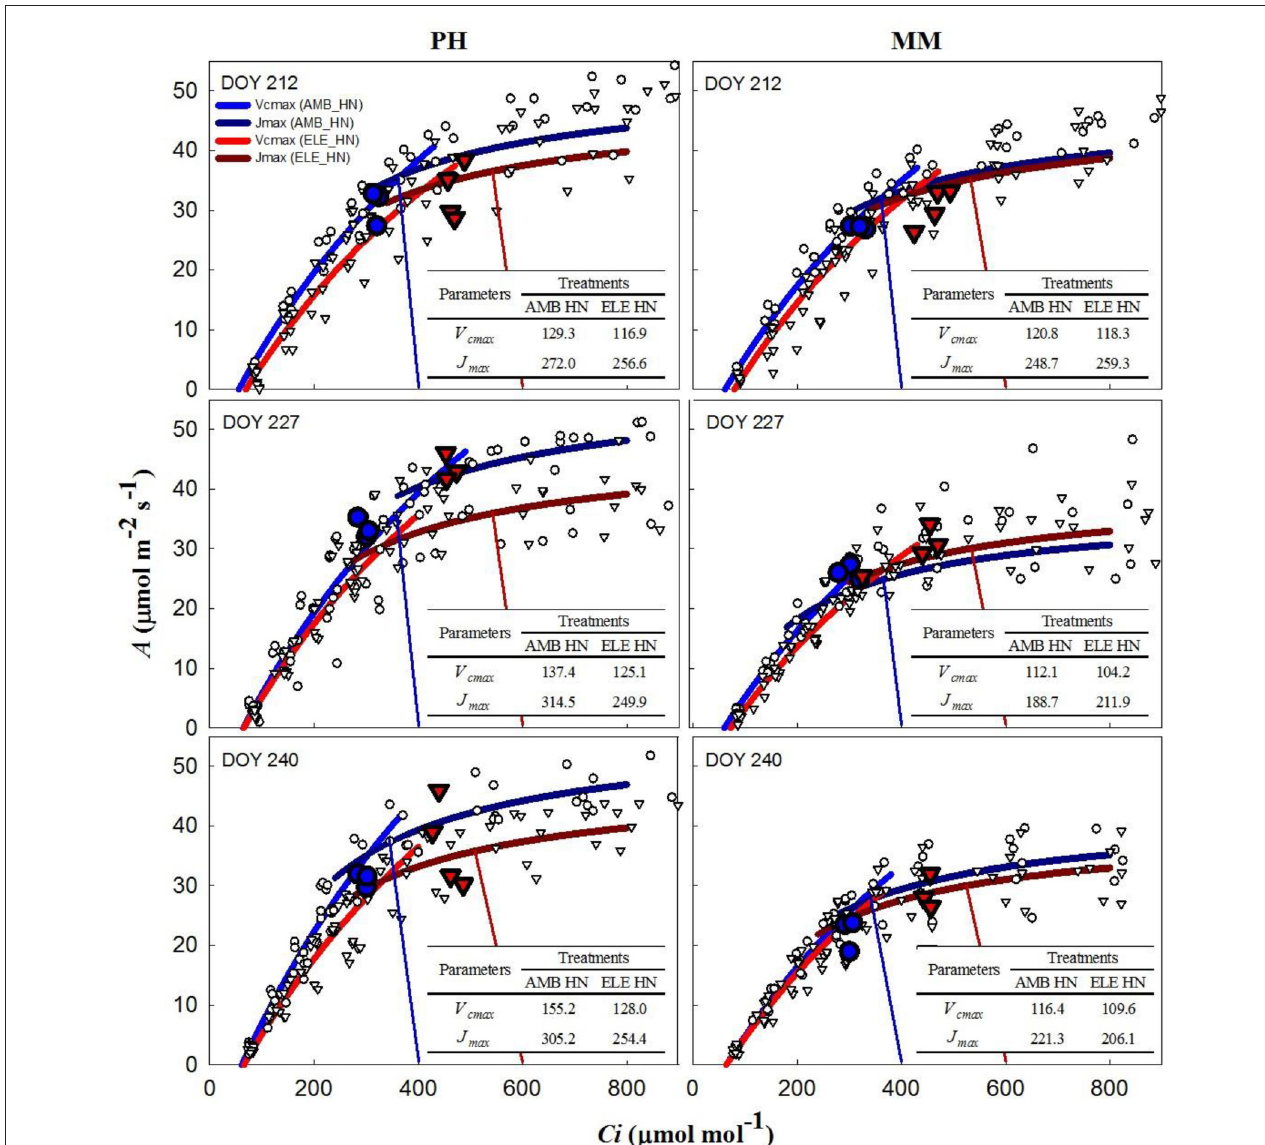
FIGURE 3 | Fitted responses of A to Ci curves. Inserted tables indicated the daily average V cmax ( µ mol m − 2 s − 1 ) and J max ( µ mol m − 2 s − 1 ) for the high N treatments in PH and MM (see also Table S4). Ambient [CO 2 ] treatments are represented by blue lines while the elevated [CO 2 ] treatments by red lines. The data to which the lines are fit, are shown by white symbols (circles are ambient [CO 2 ] and triangles are elevated [CO 2 ] treatments). The blue and red vertical lines represent the supply functions (1/- g s ) for the ambient and elevated growth [CO 2 ], respectively, intercepting the fitted A/C i at the operating point. The blue (AMB) and red (ELE) large symbols are the treatment means for the midday photosynthesis that were taken the day before of the A/C i curves. The photosynthetically active radiation (PAR) and air temperature at midday, when these measurements were made, for DOY 211, 226, and 239 were: 1,800, 2,000, and 1,600 µ mol m − 2 s − 1 and 28, 28, and 22.5 ◦ C, respectively.